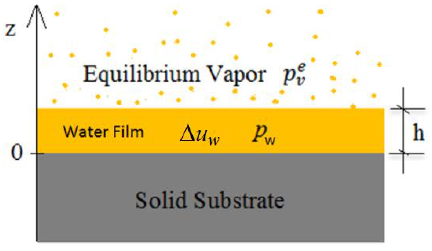
Figure 10. Water film adsorbed on a solid substrate.